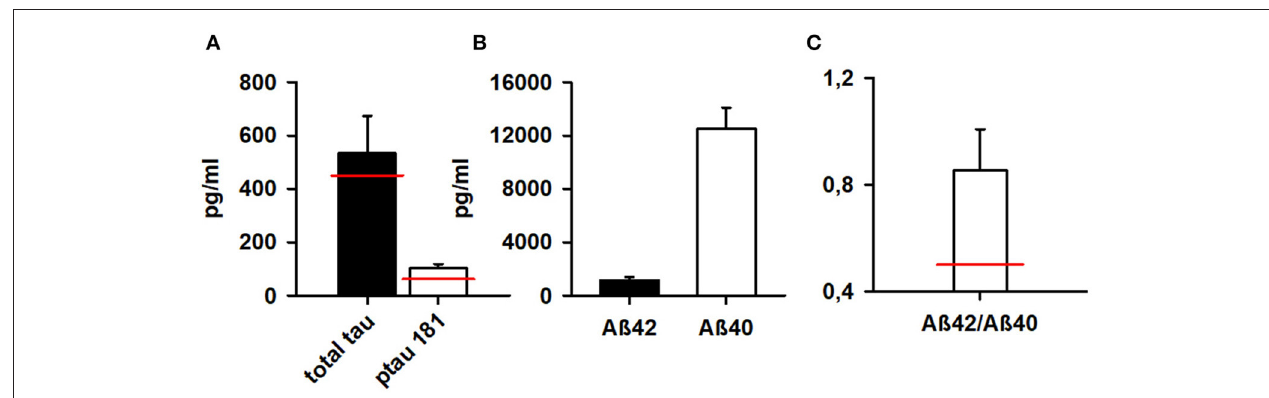
FIGURE 2 | Markers of neurodegeneration in patients. Phosphorylated tau protein 181 and total tau protein are above normal levels (A) whereas Aß42 and (B) Aß42/Aß40 ratio (C) are normal according to our normative reference values from the Neurochemistry Laboratory (see methods). Aß42, ß-amyloid 42; Aß40, ß-amyloid 40; Aß42/Aß40, ß-amyloid 42/40. The red bar indicate normal levels of neurodegenerative markers.